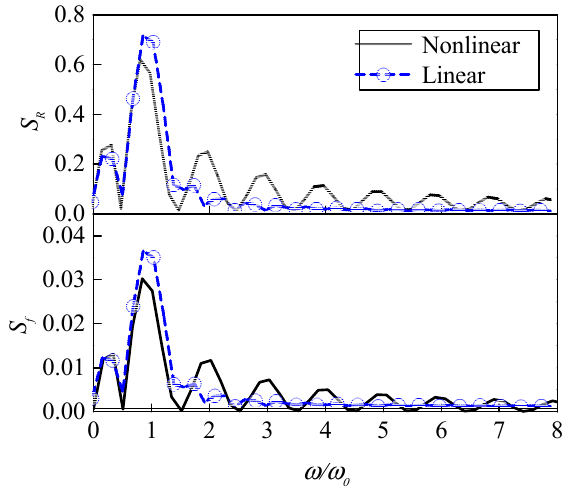
Figure 12. Spectra ofthe wave run-up and the wave force on the vertical seawall.